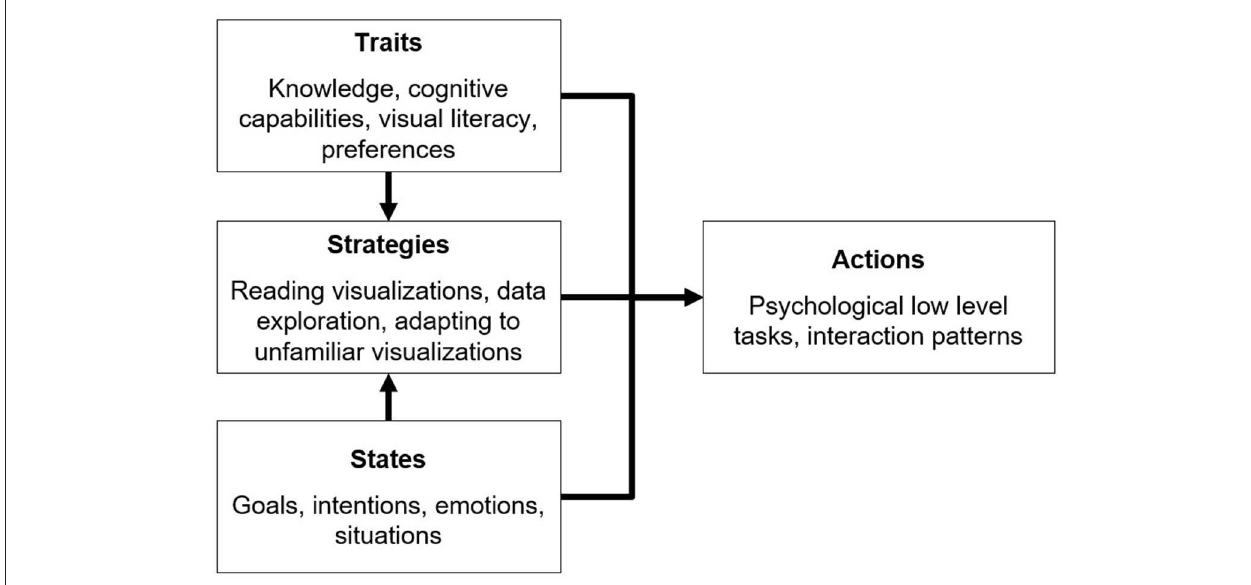
FIGURE 1 | Modeling aspects of user-adaptive data